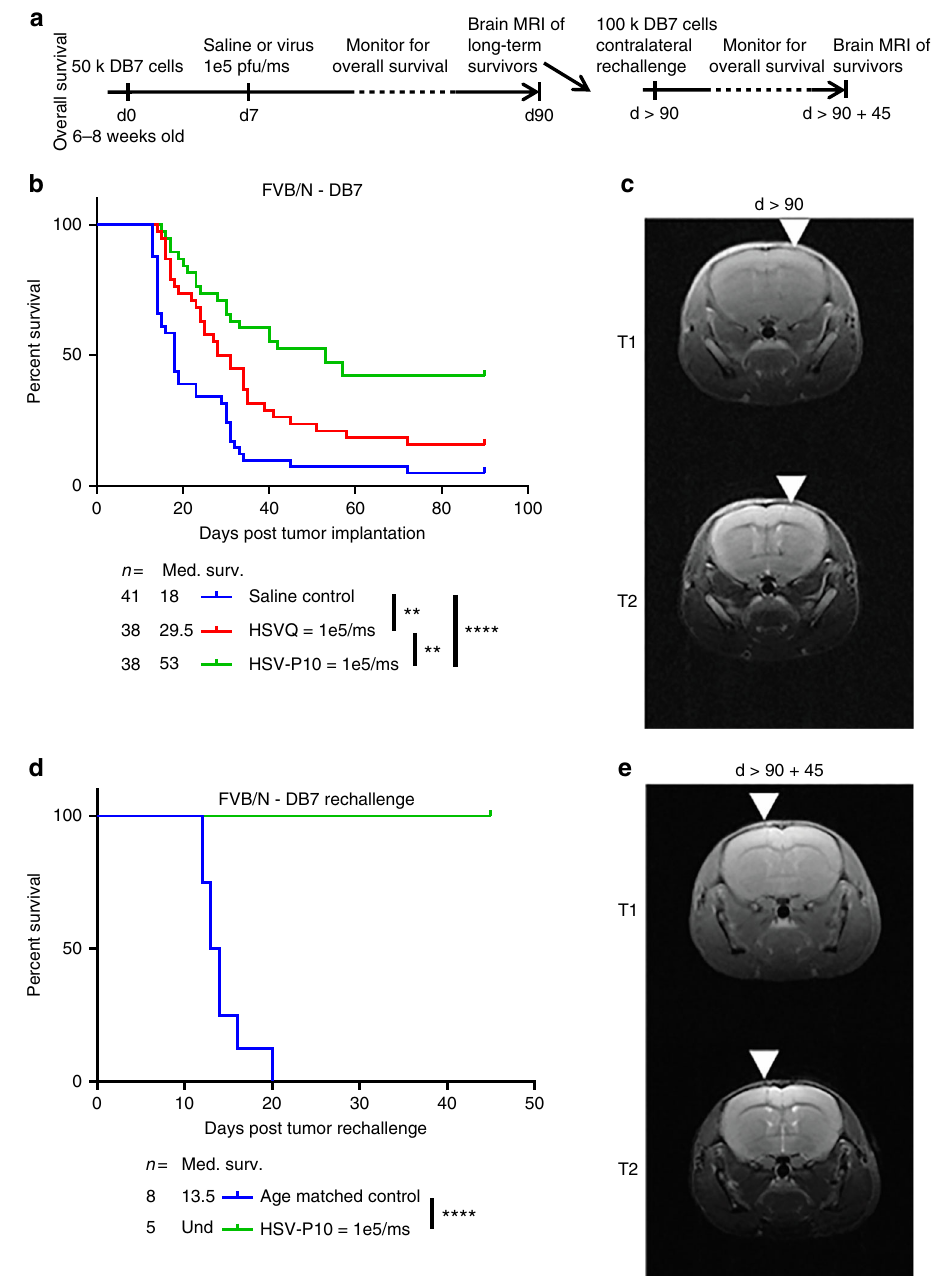
Fig. 6 HSV-P10 enhances overall survival of mice bearing breast cancer brain metastases. a Schematic representation of animal studies. b Survival curve of DB7 brain tumor-bearing FVB/N mice treated intratumorally with saline control (blue line: n = 41), HSVQ (red line: n = 38), or HSV-P10 (green line: n = 38) 7 days post tumor cell implantation. Signi fi cance in survival was assessed by Logrank (Mantel – Cox) test comparing only two survival curves per test (** p < 0.01, **** p < 0.0001). c Brain magnetic resonance imaging (MRI) of one representative long-term survivor mouse treated with HSV-P10 from Fig. 5b > 90 days post tumor cell implantation. White arrows indicate the needle track of the initial injection site. d Survival curve of HSV-P10 treated long-term survivor mice (green line: n = 5) from Fig. 5b contralaterally inoculated with 100,000 DB7 tumor cells vs. naive age-matched control mice (blue line: n = 8). Signi fi cance in survival was assessed by Logrank (Mantel – Cox) test (*** p < 0.001). e Brain MRI of one representative long-term survivor mouse from Fig. 5d 45 days post tumor rechallenge. White arrows indicate the needle track of the rechallenge injection tumor burden, indicating that CD8 + T-cells are essential for the long-term survival bene fi t of HSV-P10 treatment in vivo.